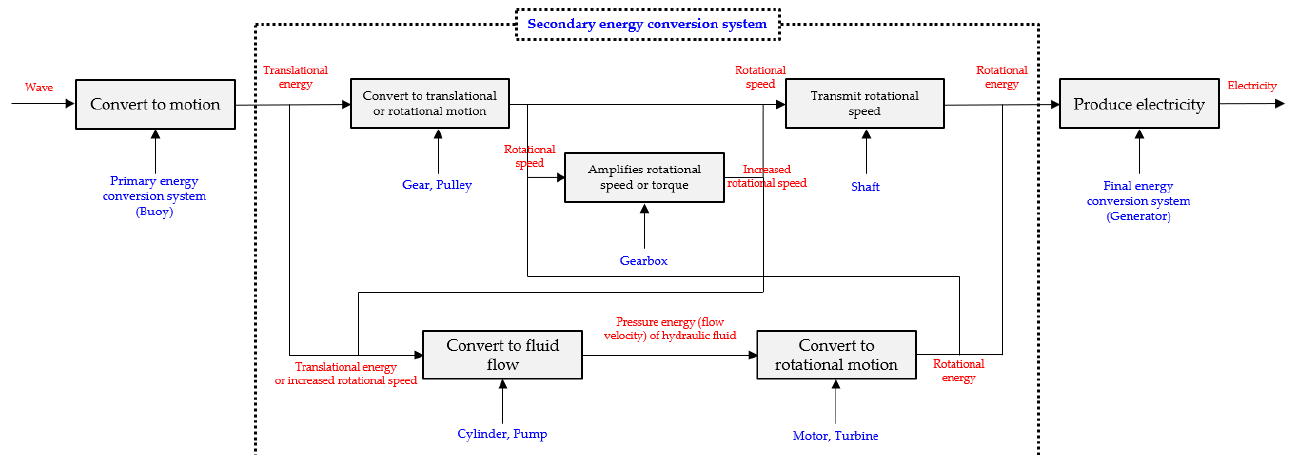
Figure 3. IDEF0 basic formalism.